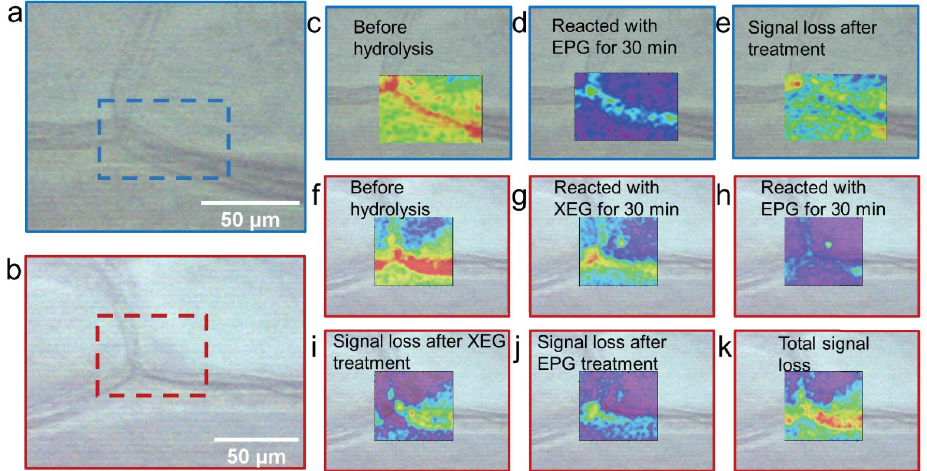
Fig 5. The Raman images of samples after enzymatic treatments. (a), (b) showed the optical image of sampled areas of samples that were treated with EPG enzyme only, and the sample treated with XEG and EPG in sequence, respectively. (c), (d) showed the Raman images of the sample before and after the EPG treatment. (e) shows the Raman image of Raman intensity differences before and after the EPG treatment. (f), (g), (h) showed the Raman image of the sampled area before the treatments, after XEG treatment, and after EPG treatment, respectively. (i), (j), (k) showed the Raman intensities change before and after XEG treatment, before and after EPG treatment, and the total intensity change after XEG and EPG treatment. All the Raman images were constructed based on the 4ATP signature peak at 1573 cm − 1